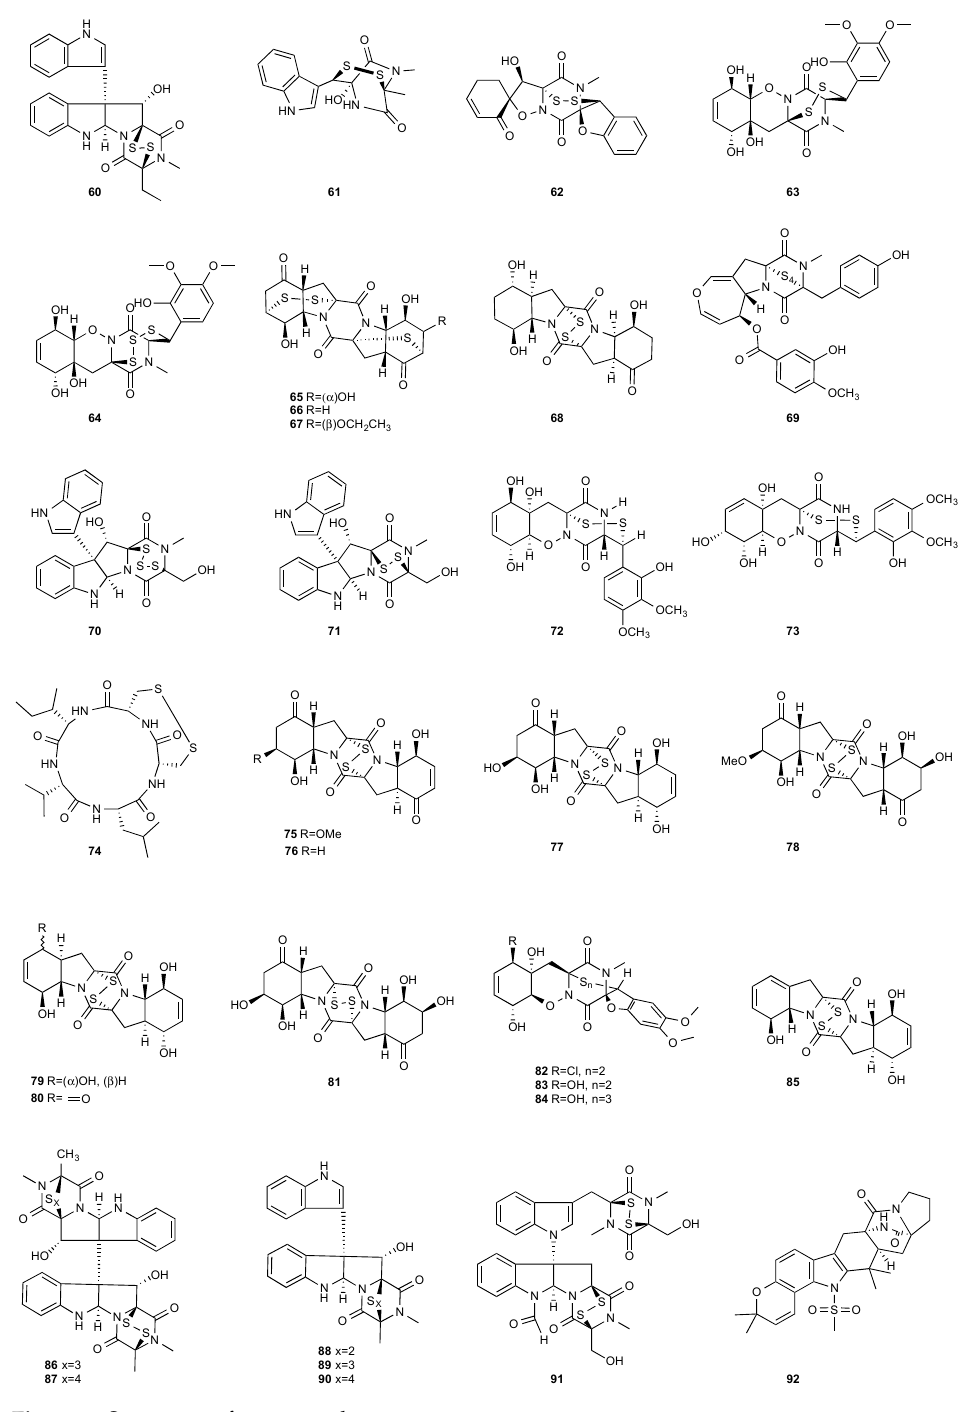
Figure 3. Structures of compounds 60 – 92 .